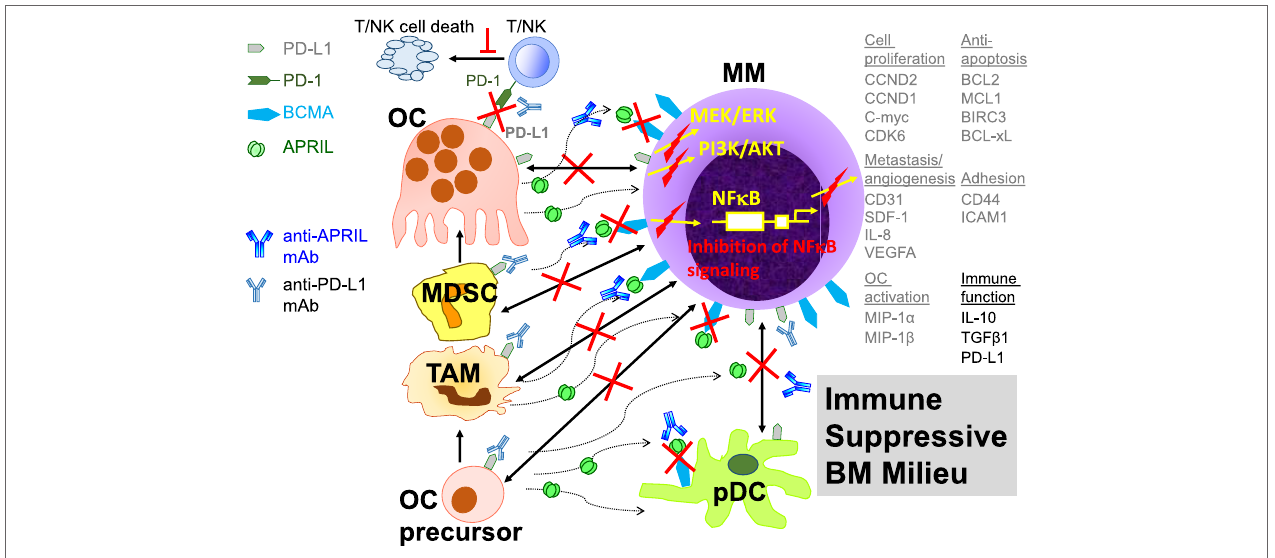
FigURe 3 | Targeting a proliferation-inducing ligand (APRIL) and programmed cell death ligand 1 (PD-L1) to overcome OC-mediated immune suppression in the multiple myeloma (MM) BM milieu. APRIL is secreted by myeloid lineage cells including OCs, OC precursors, tumor-associated macrophages, and MDSCs, in the BM. MDSCs induced by MM cells further differentiate into functional OCs. Besides the induction of critical downstream targets (listed in gray on the right), APRIL induces PD-L1 on MM cells via BCMA, a specific MM antigen. This positive feedback loop between MM cells and MM-supporting cells, coupled with increased PD-L1 expression, further inhibits effector-mediated MM cell lysis via binding to programmed cell death protein 1 (PD-1) on activated T and natural killer (NK) effector cells. Blocking PD-1/PD-L1 and APRIL monoclonal antibodies prevent these effects and may mitigate immune suppression in MM. Adapted from Ref. (20, 145). TAM, tumor-associated antigen; MDSC, myeloid-derived suppressor cells; BCMA, B cell maturation antigen; T/NK, immune effector cells; pDC, plasmacytoid dendritic cell. Red lines indicate inhibition in the presence of these blocking monoclonal antibodies; double arrow lines depict